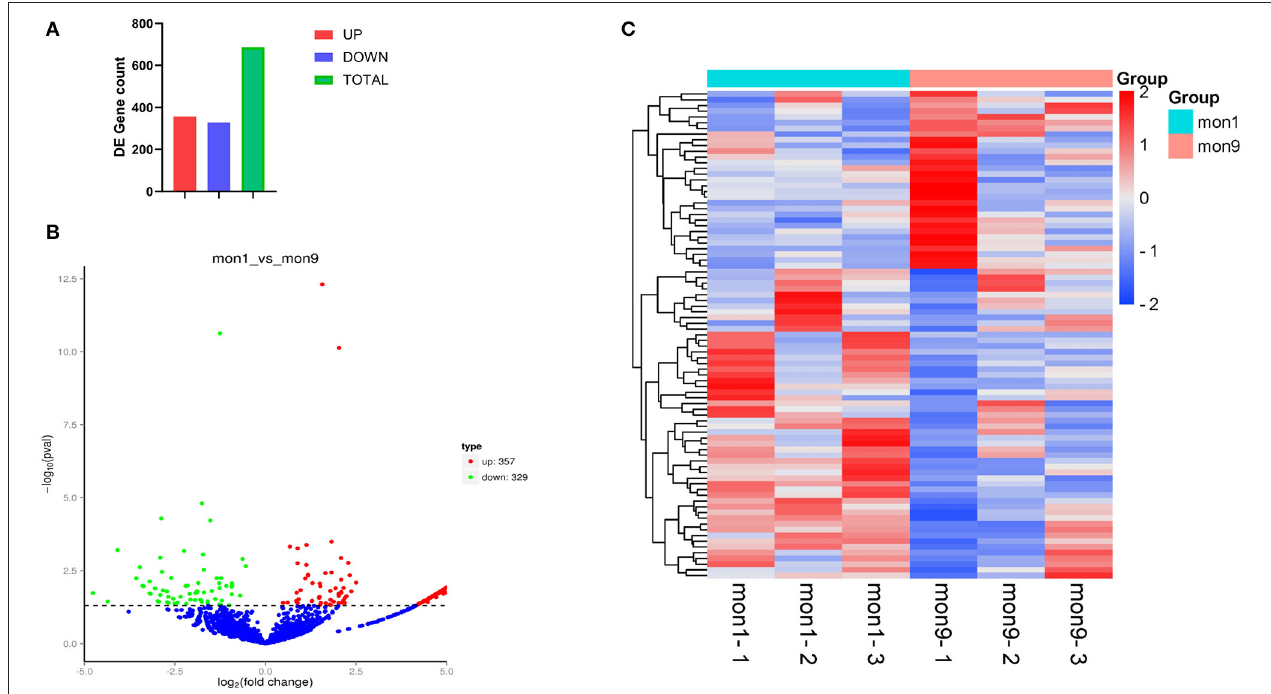
FIGURE 4 | Differentially expressed circRNAs. (A) All 686 differentially expressed circRNAs, of which 357 were upregulated and 329 were downregulated. (B) Visualization of the differential expression in a volcano graph. The abscissa is the fold change of expression in the mon1 and mon9 samples, and the ordinate is the statistical significance of the expression change. Different colors indicate different classifications: green (downregulated) and red (upregulated). (C) Clustering heatmap of differentially expressed genes. The change in expression level is indicated by the change in color, with blue indicating a lower expression level and red indicating a higher expression